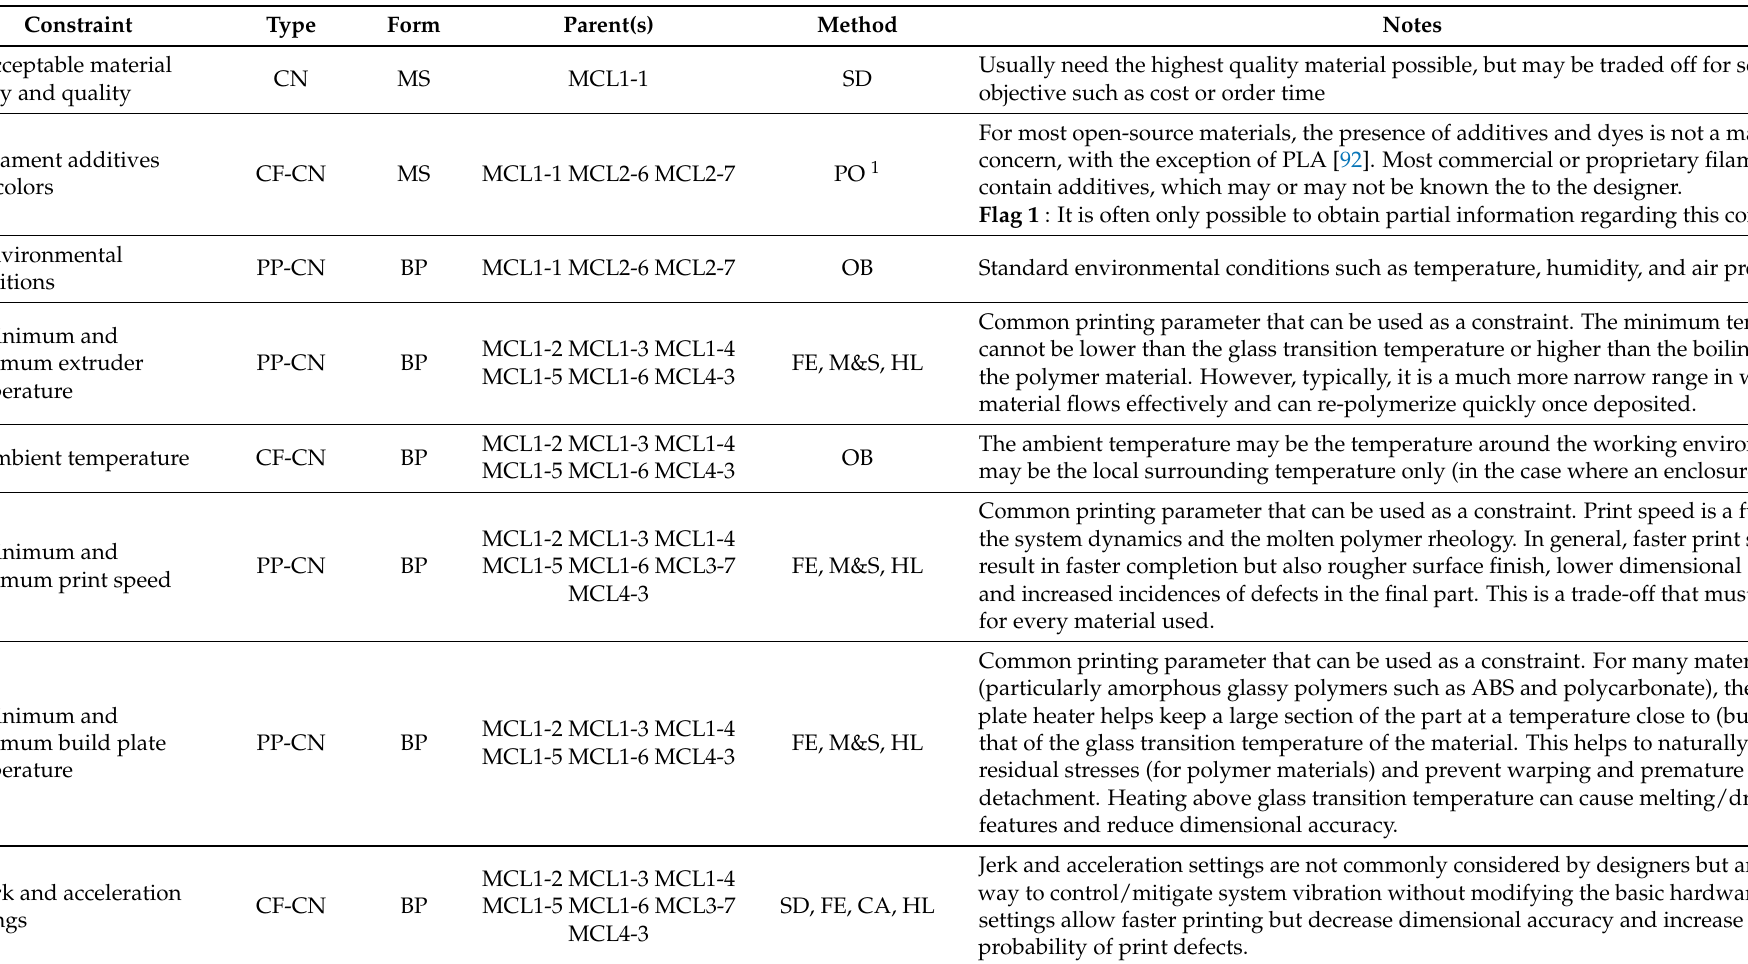
Table 3. Manufacturability constraints mapped from the manufacturing constraints and manufacturing consideration for the FDM process. These constraints are subject to three major assumptions: (1) The system has three degrees of freedom, (2) the extruder has a fixed round extrusion nozzle, and (3) the printer hardware is properly tuned. Definitions for the terms in the type, form, parent(s), and method columns are provided, mainly in Section